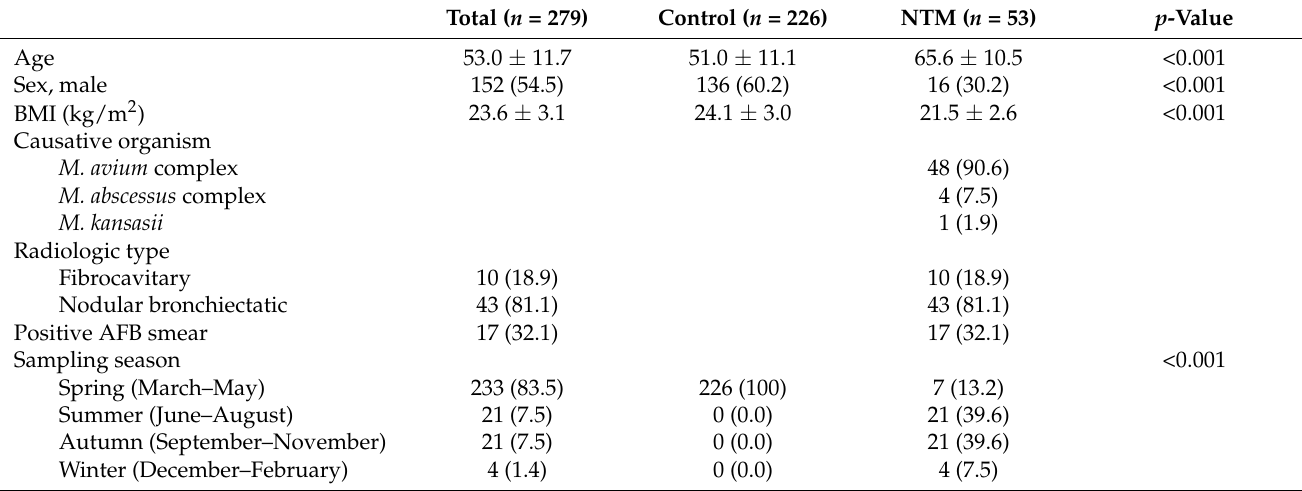
Table 1. Comparison of baseline characteristics of participants according to the diagnosis.